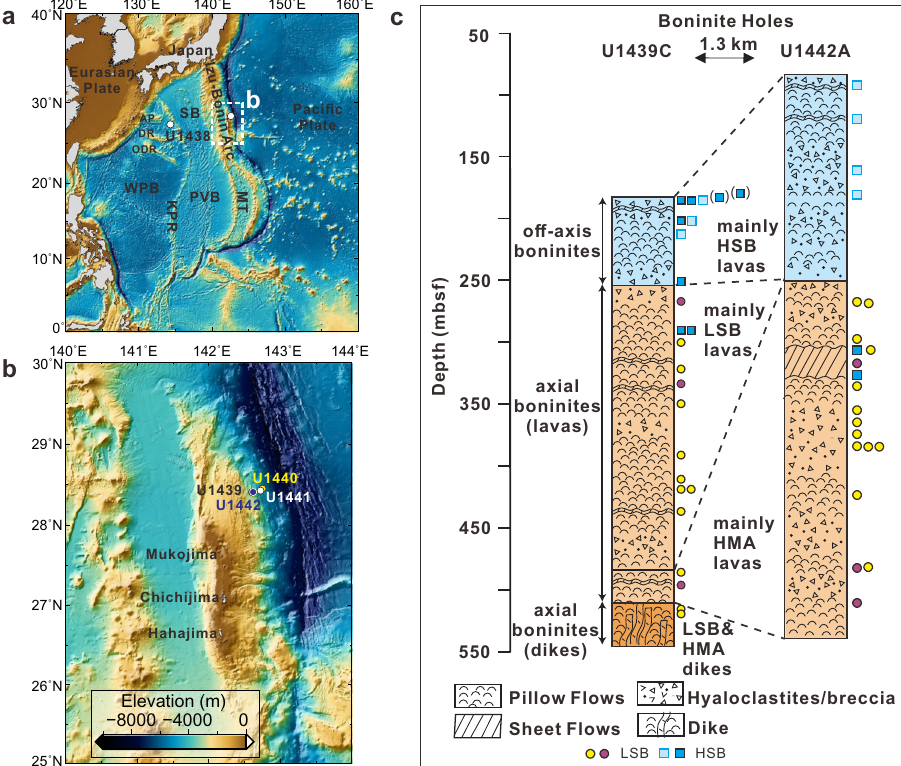
Fig. 1 Regional map of the Izu-Bonin-Mariana convergent plate margin with sampling locations. a , b Locations of the International Ocean Discovery Program Expedition 352 drill sites in the Izu-Bonin forearc, Western Paci fi c. U1439 and U1442 are boninite sites, while U1440 and U1441 are forearc basalt sites. c Simpli fi ed logs for the two boninite holes (U1439C and U1442A), recovering lavas and dykes mainly of high-silica (HSB) and low-silica (LSB) boninites and their differentiation products, high magnesium andesites (HMA). The depths in the cores for each sample examined this study and HSB samples from Li et al. 4 (light blue squares) are plotted alongside the core logs. The depth of two HSB samples from hole U1439A (In brackets) are also plotted alongside hole U1439C. For the purposes of this study HMA differentiates are not distinguished from their parental HSB or LSB. SB: Shikoku Basin; PVB: Parece Vela Basin; MT: Mariana Trough; KPR: Kyushu Palau Ridge; WPB: West Philippine Basin; AP: Amami Plateau; DR: Daito Ridge; ODR: Oki-Daito Ridge; mbsf: meters below the sea fl